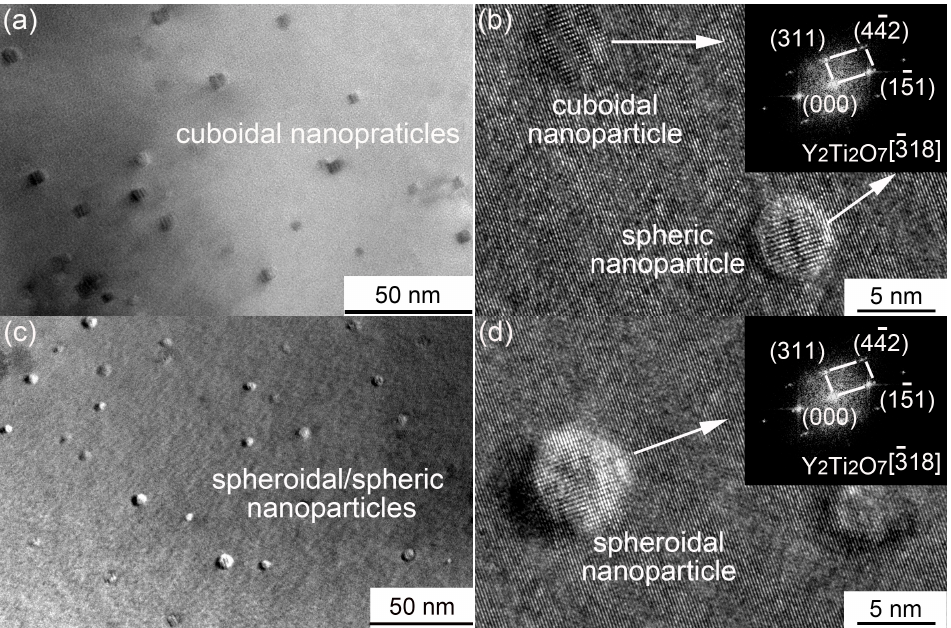
Figure 13. Nanoparticles in the MX steel: ( a ) TEM image of cuboidal nanoparticles; ( b ) HRTEM image of cuboidal and spheric nanoparticles with the corresponding fast fourier transform (FFT) pattern; ( c ) TEM image of spheroidal/spheric nanoparticles; ( d ) HRTEM image of spheroidal nanoparticle with the corresponding FFT pattern.